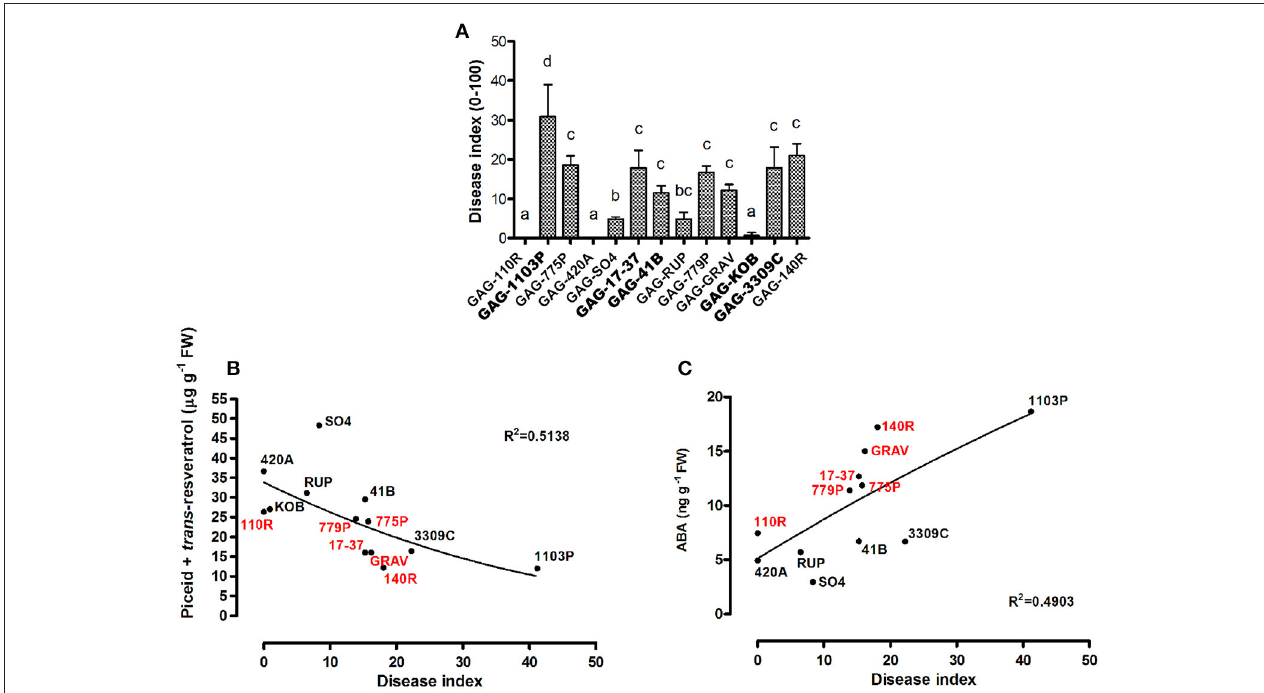
FIGURE 7 | Evaluation of disease resistance of scion leaves of 13 graft combinations against Plasmopara viticola . The Disease Index (DI) is expressed as the percentage of infected leaves. Lower case letters above bars denote significant differences by Tukey’s HSD-test ( P < 0.05). Data are expressed as mean ± SD ( n = 3) (A) . The correlations between the disease index and the amount of piceid and trans-resveratrol ( p < 0.05) (B) and between the disease index and the ABA content ( p < 0.05) (C) related to each graft combination are plotted. Red and black labels are used to underline how graft combinations group according to the negative (B) or positive (C) correlation. The combinations chosen for RNA-seq analyses are indicated in bold